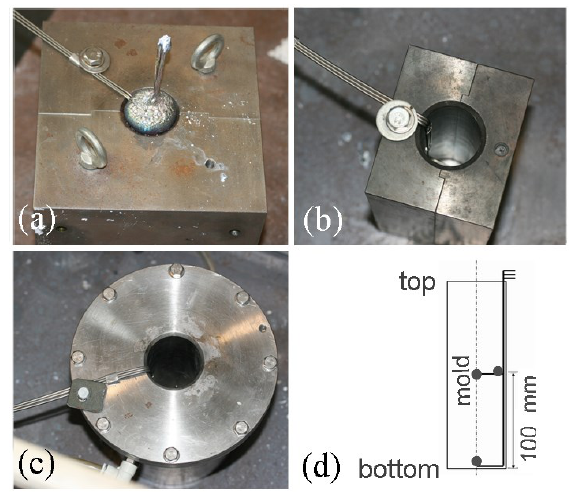
Figure 1. Appearance of the ( a ) chill cast, ( b ) conventional cast and ( c ) water-cooled molds, and ( d ) the location of